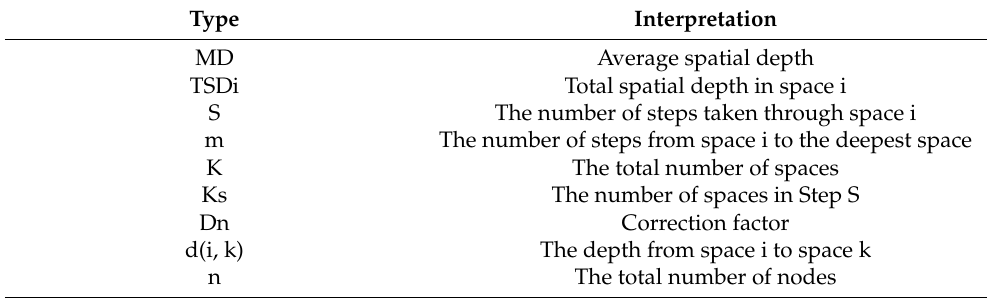
Table 1. The interpretation of space–syntax expressions.